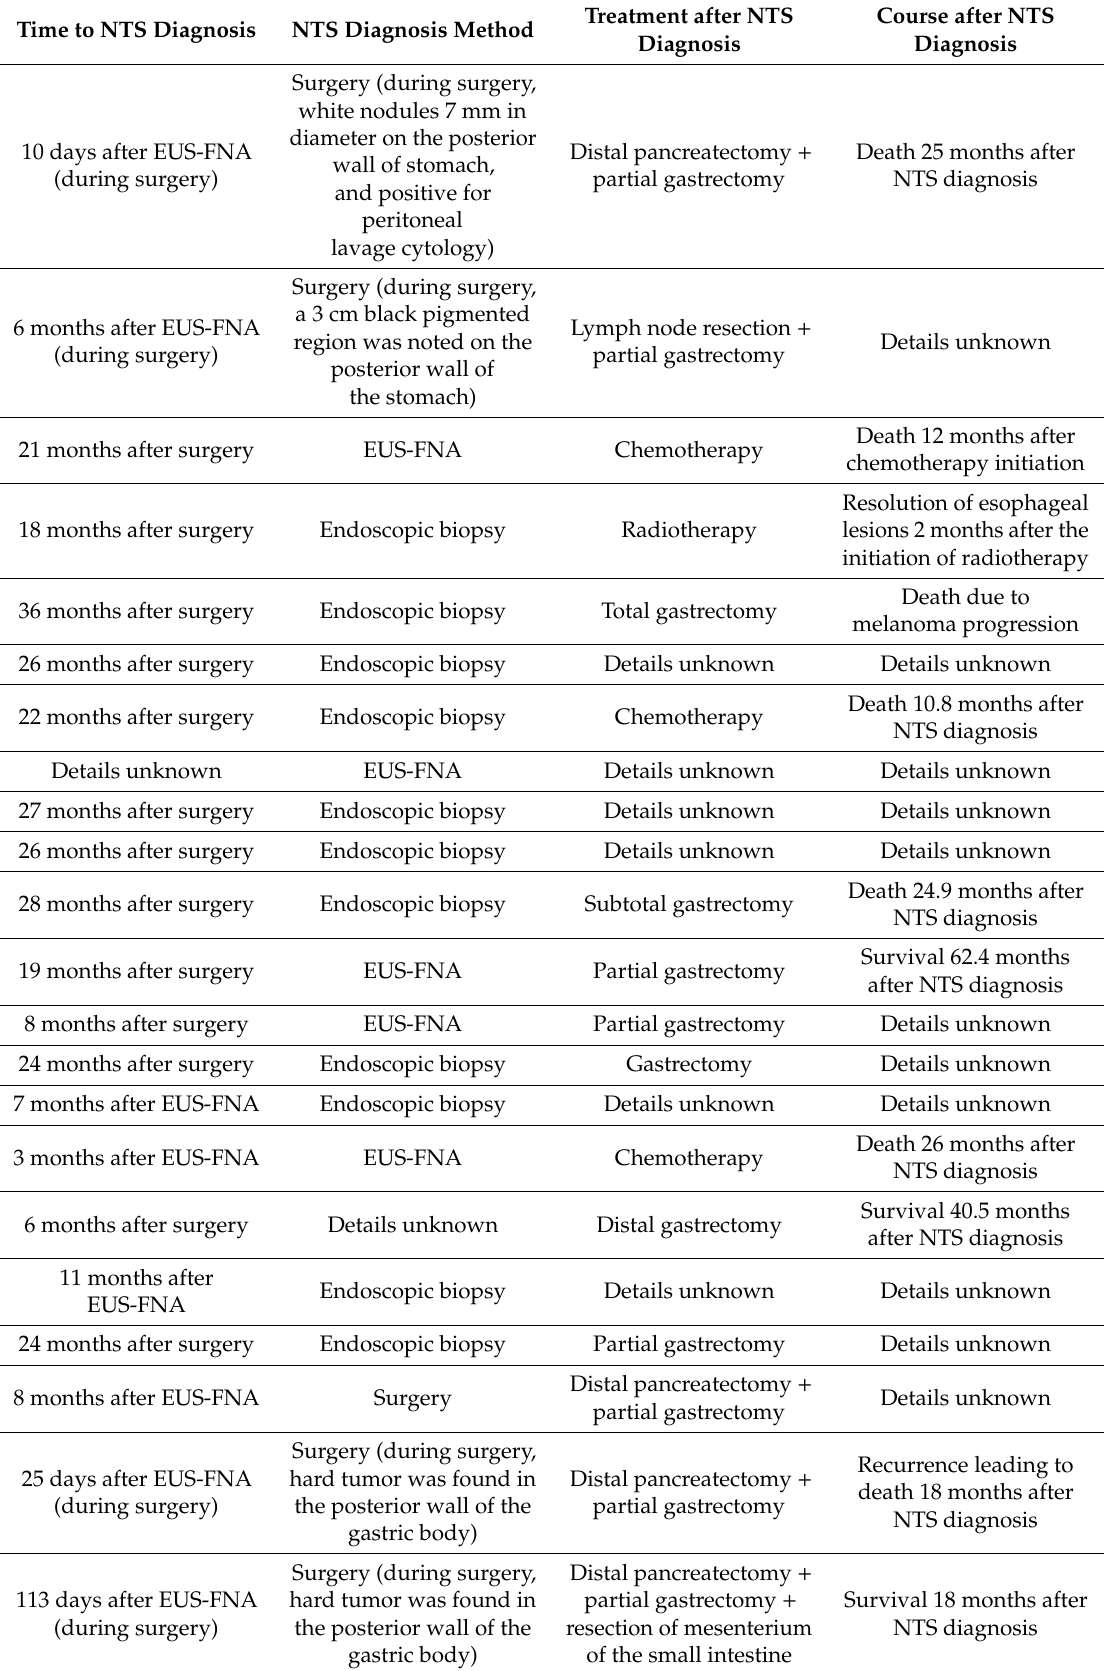
Table 4. Time, mode, treatment, and post-treatment course after NTS